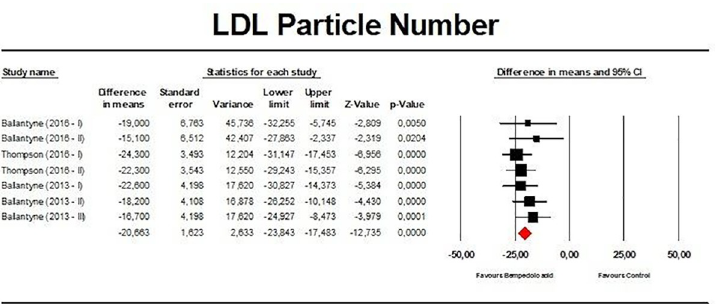
Fig 5. Forest plot displaying mean difference and 95% confidence intervals for the effect of bempedoic acid on plasma levels of low-density lipoprotein (LDL) particle number.